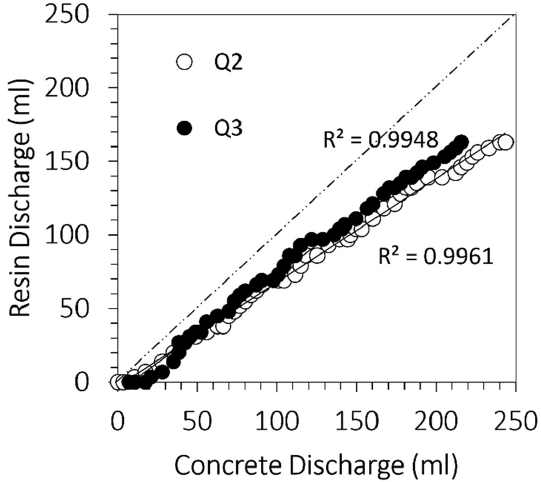
Figure 6. Comparison between the discharge rates along the outlet sections Q2 and Q3, obtained from experiments conducted on concrete and resin fracture surfaces. A comparison between the flow path in the dry fracture and the aperture distribution indicates that the first capillary zones are distributed around the area with apertures less than 1.8 mm . In these areas, capillary forces are enough to overcome the gravitational force, whereas the thin flow channels are observed near the largest apertures. Thus, the width of these capillary zones is influenced by the ratio of gravity force to capillary force, which is a function of fracture inclination. The Bond number (Bo) corresponding to the ratio of gravity force to capillary force, considering the epoxy resin surface tension (0.066 (cid:3015) ), contact angle (63°), viscosity of dyed water ( 1.01 (cid:3400) 10 (cid:2879)(cid:2871) (cid:3038)(cid:3034) ), and fracture inclination (cid:3040)(cid:3046) (cid:3040) angle ( β = 45 ° ) is approximately